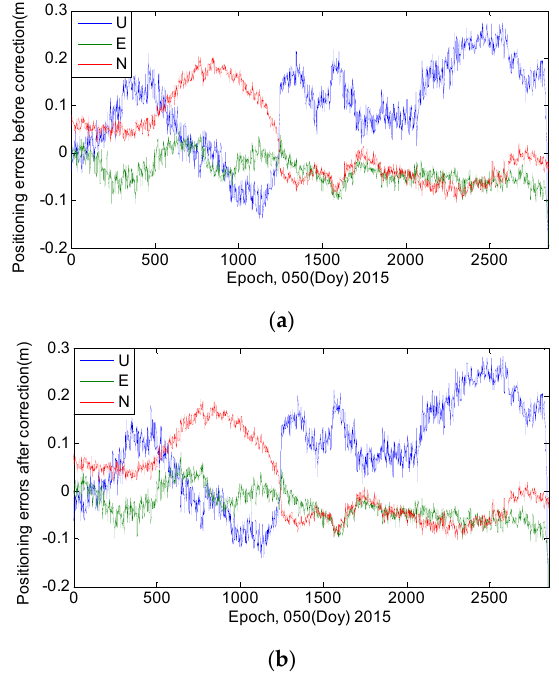
Figure 21. The position estimations of the kinematic PPP approach by using ionosphere-free combinations of the first and the second frequencies. ( a ) Represents the positioning errors before applying the correction model; ( b ) Represents the positioning errors after applying the correction model.